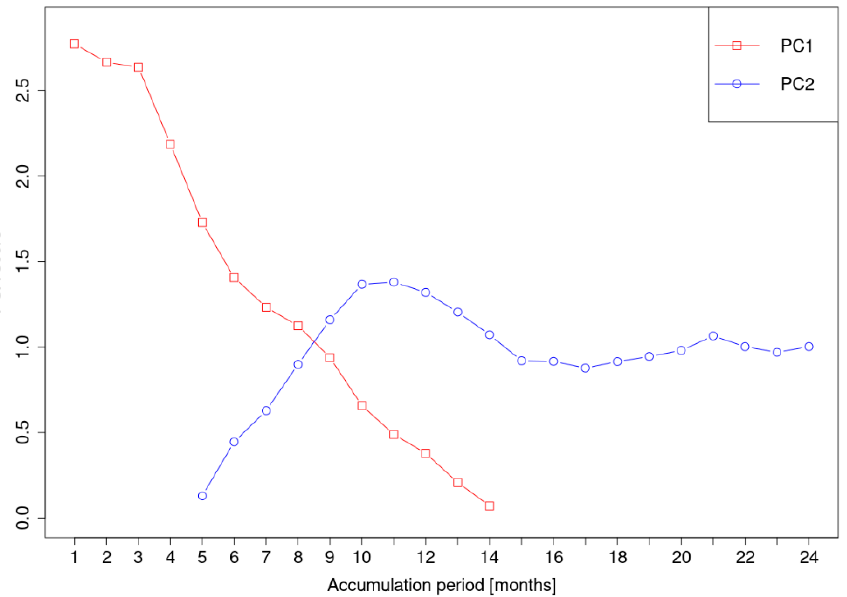
Figure 7. Principal component scores (varimax rotated) for the complete correlation series between SPEI and SSI for different SPEI accumulation periods.